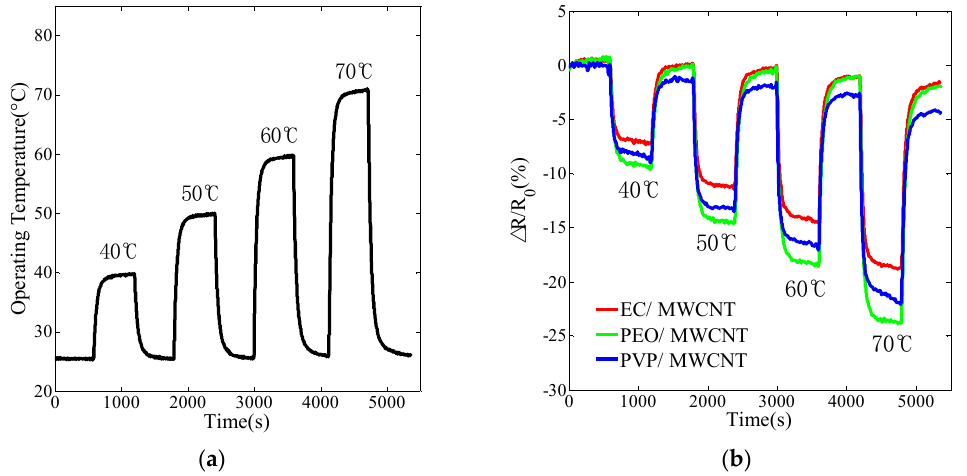
Figure 5. Cyclical heating to operating temperatures of 40 °C, 50 °C, 60 °C, and 70 °C. ( a ) the transient response of the heater to the relative operating temperature; and ( b ) the responses of normalized resistance of the polymer/MWCNT composite sensor.